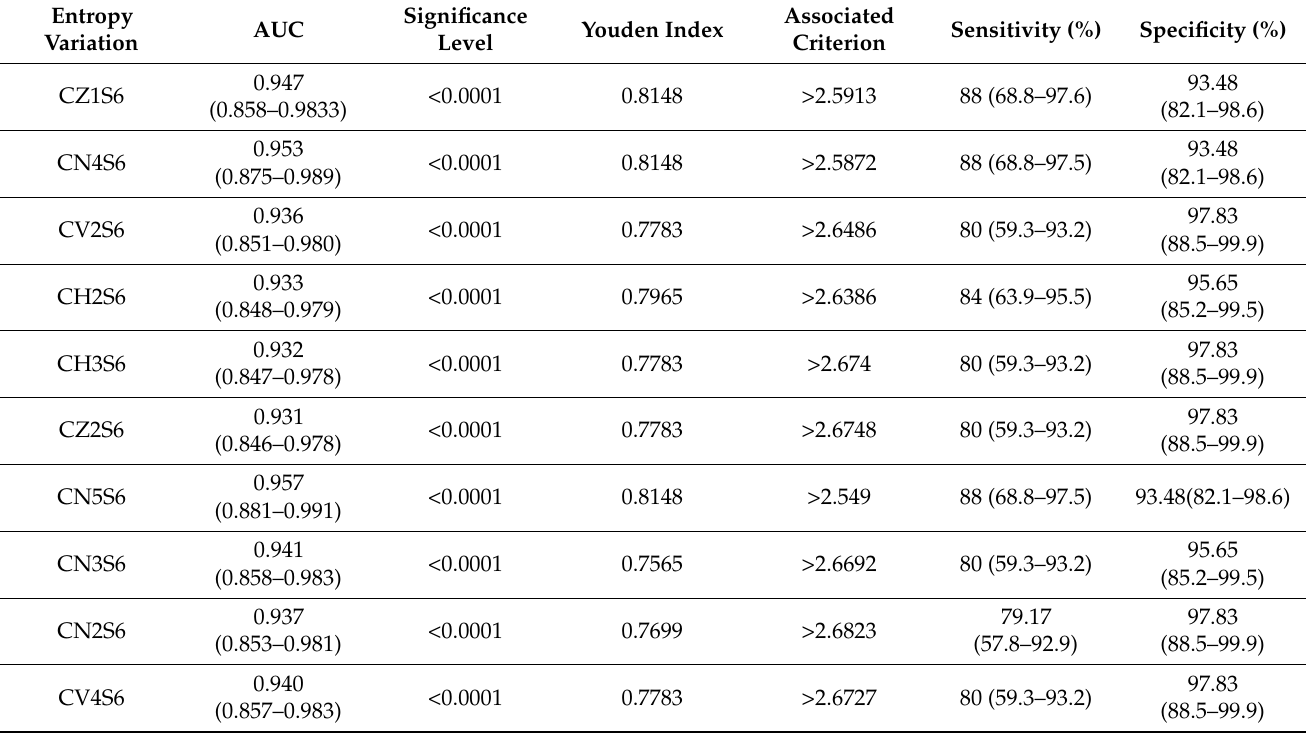
Table 3. Receiver operating characteristic analysis results of the parameters that showed statistically significant results at the univariate analysis.